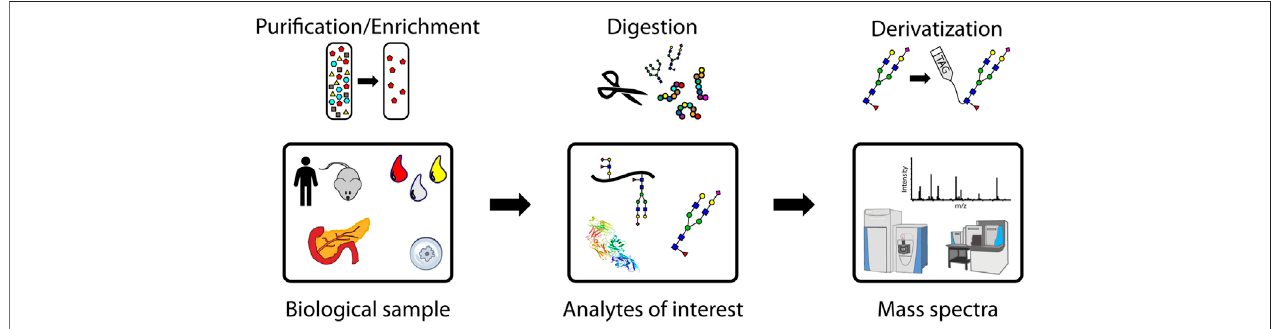
FIGURE 1 | A representative work fl ow for mass spectrometry-based glycoproteomic analyses. Puri fi cation/enrichment, digestion, and derivatization of analytes may be performed at the glycoprotein, glycopeptide, and glycan